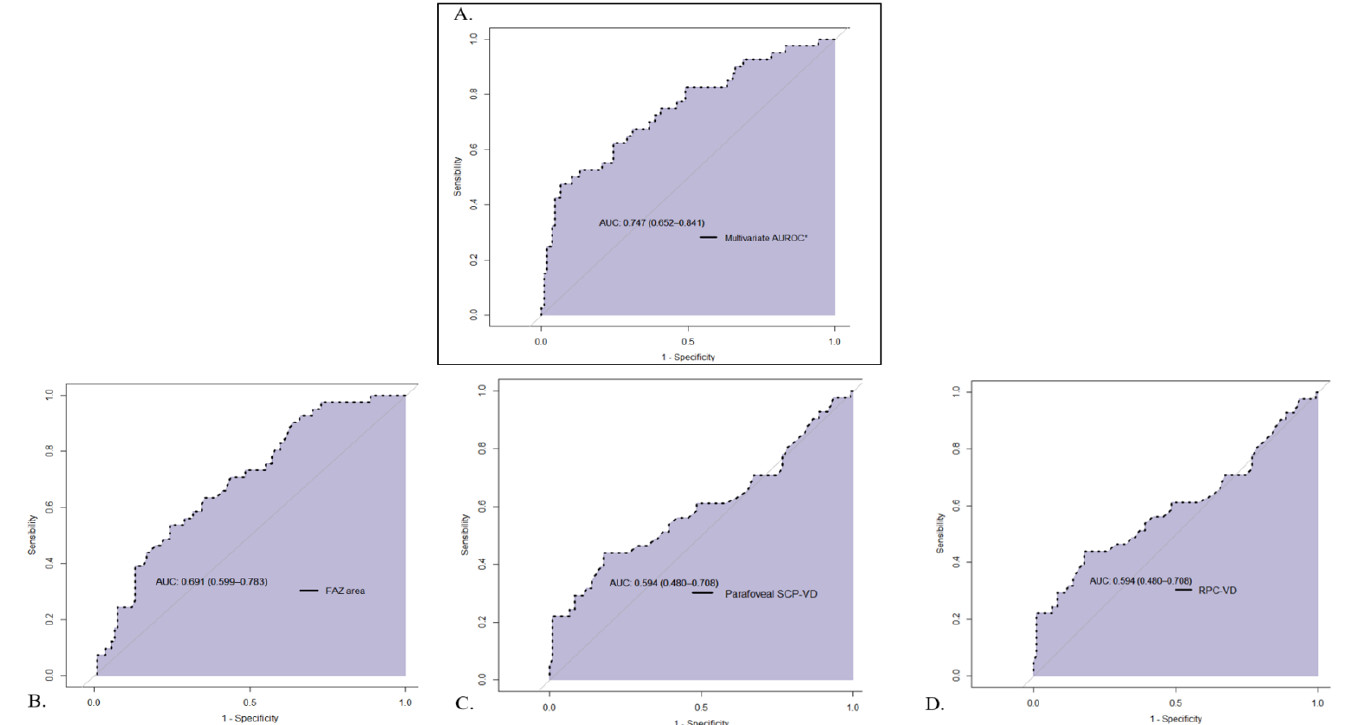
Figure 4. Ability of OCT-A to stage Crohn’s disease severity, area under the receiver operating characteristic curve (AUC). Area under the receiver operating characteristic curve (AUC) values were ascertained for significant microvascular features by using logistic regression, with diagnosis of severe CD as the outcome variable. The multivariate AUC and the AUC values for the independent factors used for the multivariate AUC analysis are plotted. ( A ) Multivariate AUC (based on the non-correlated and significant parameters; i.e., FAZ, RPC-VD and parafoveal SCP-VD); ( B ) FAZ area AUC; ( C ) Parafoveal SCP-VD AUC; ( D ) RPC-VD AUC. Abbreviations: AUC — area under the receiver operating characteristic curve; FAZ — foveal avascular zone; RPC — radial peripapillary capillaries; SCP — superficial capillary plexus; VD — vascular density.